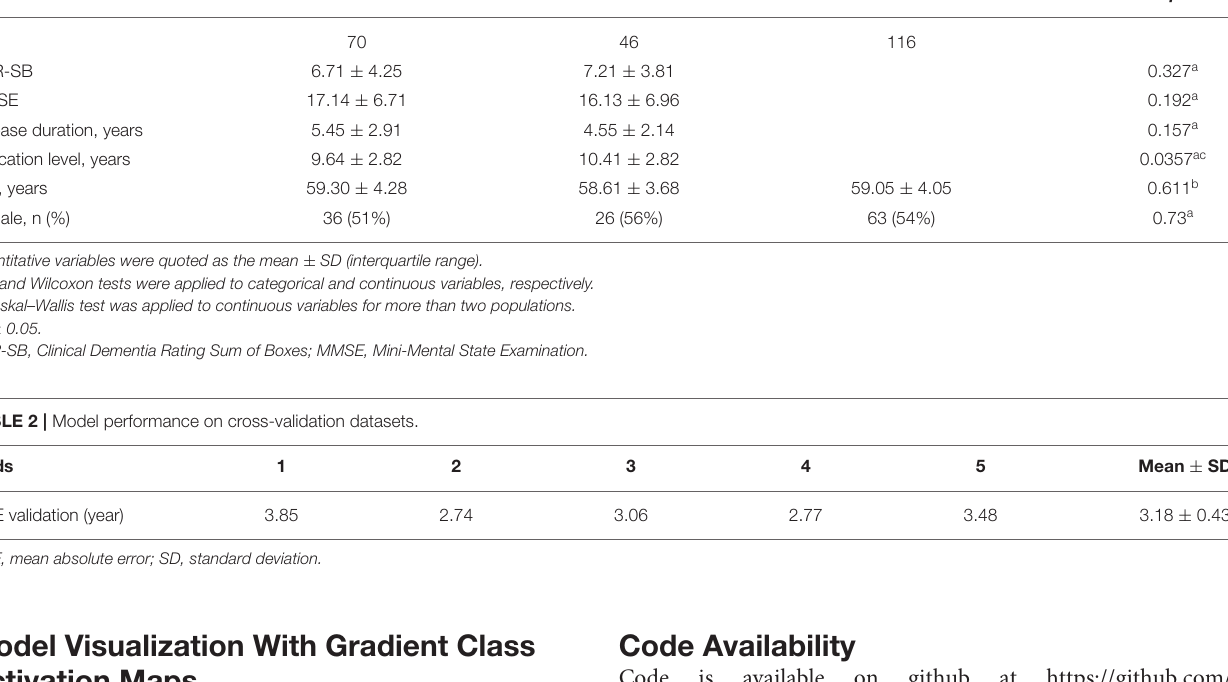
TABLE 1 | Demographic and clinical characteristics at baseline according to clinical forms of EOAD and controls. Indicators